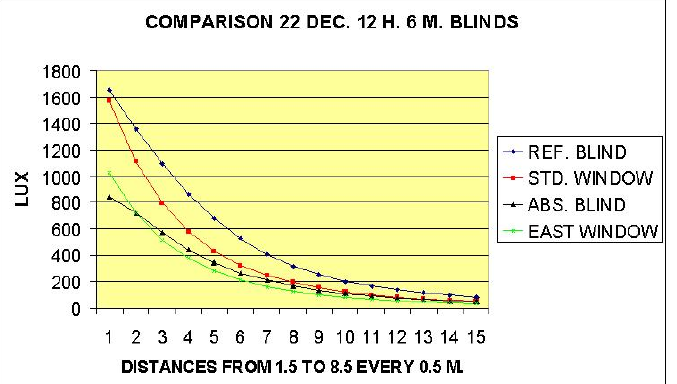
Figure 10. Raymond’s Golconde Ashram: computer simulation (section) of the performance of the current louvers (blue diamonds), dark-painted slats (black triangles), and the same window without blinds oriented to the south (red squares) or to the east (green “x”). The existing system, if set to a horizontal position, increases illuminance significantly as compared with a normal window.